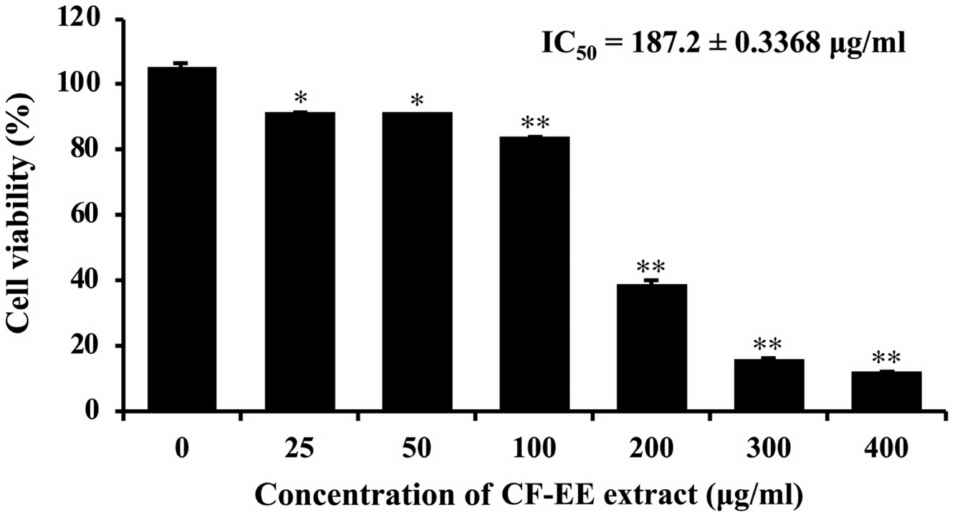
Figure 2. CF-EE extract inhibited cell growth in HeLa cells. The cells were treated with CF-EE extract at various concentrations for 24 h and MTT assay was performed. The IC 50 of the CF-EE extract was